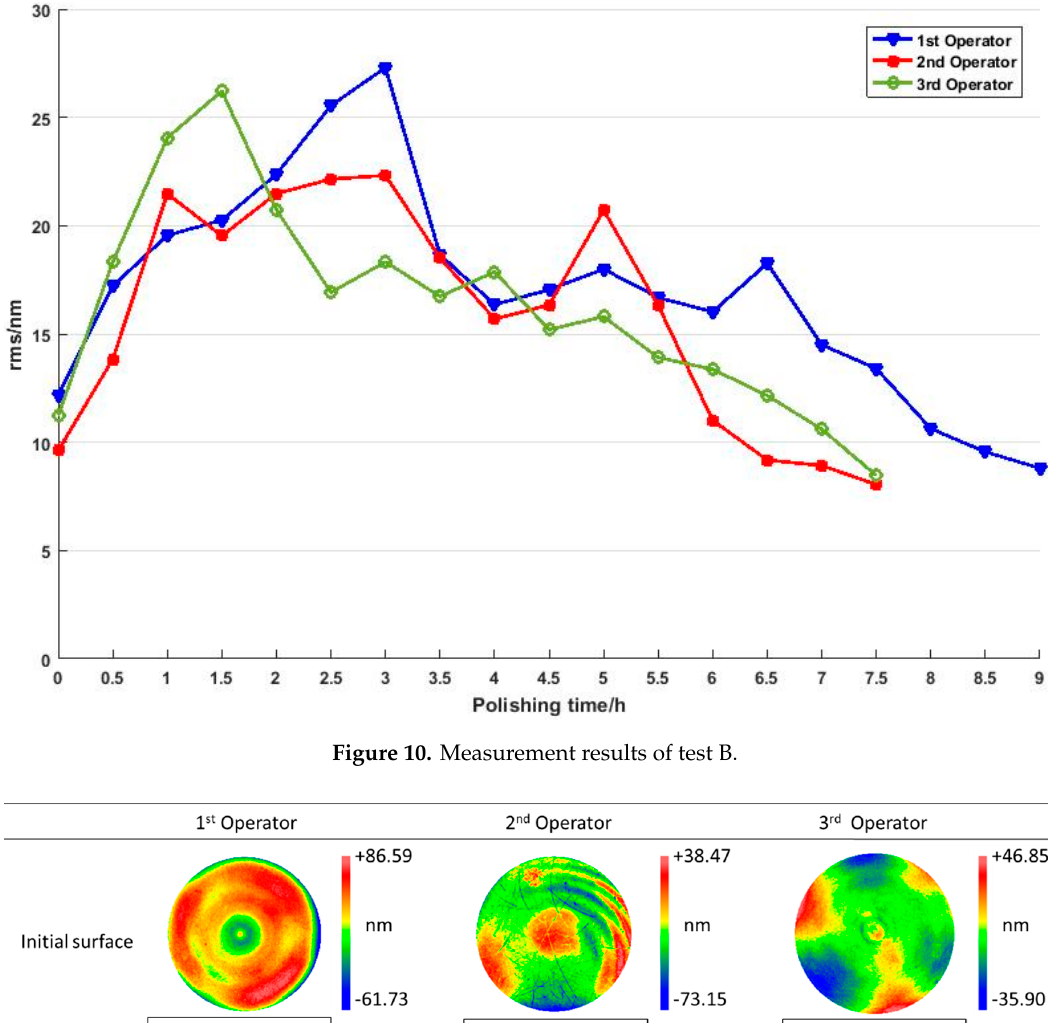
Figure 10. Measurement results of test B.